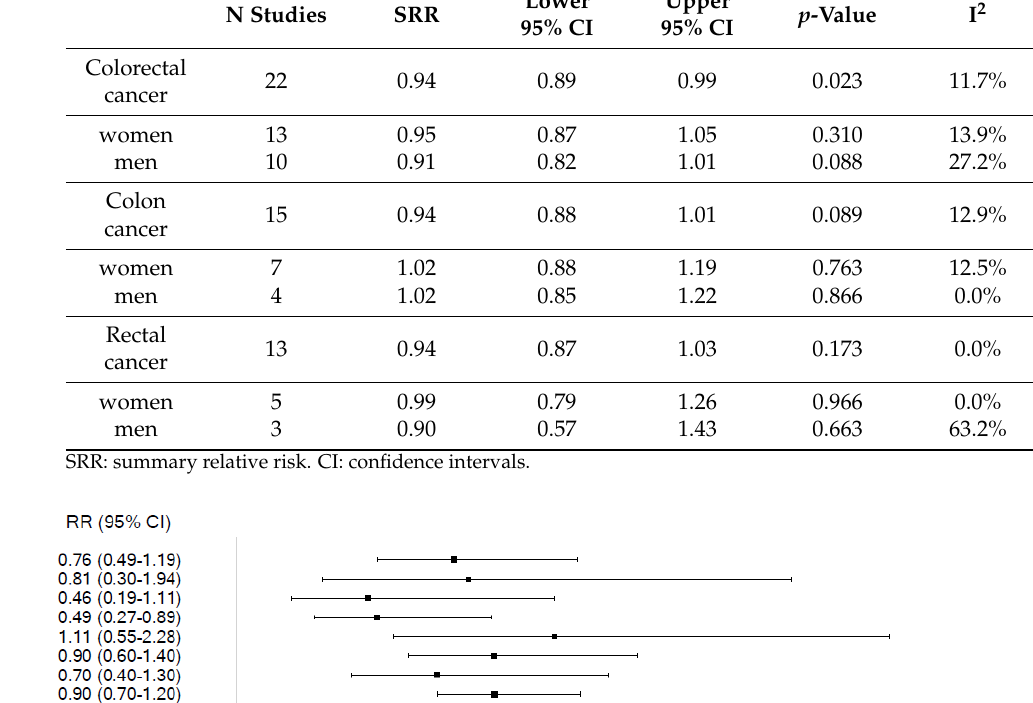
Table 2. Meta-analysis of studies for the association between fish consumption (highest vs. lowest category of consumption) and colorectal cancer risk, overall and stratified by tumor site and sex.